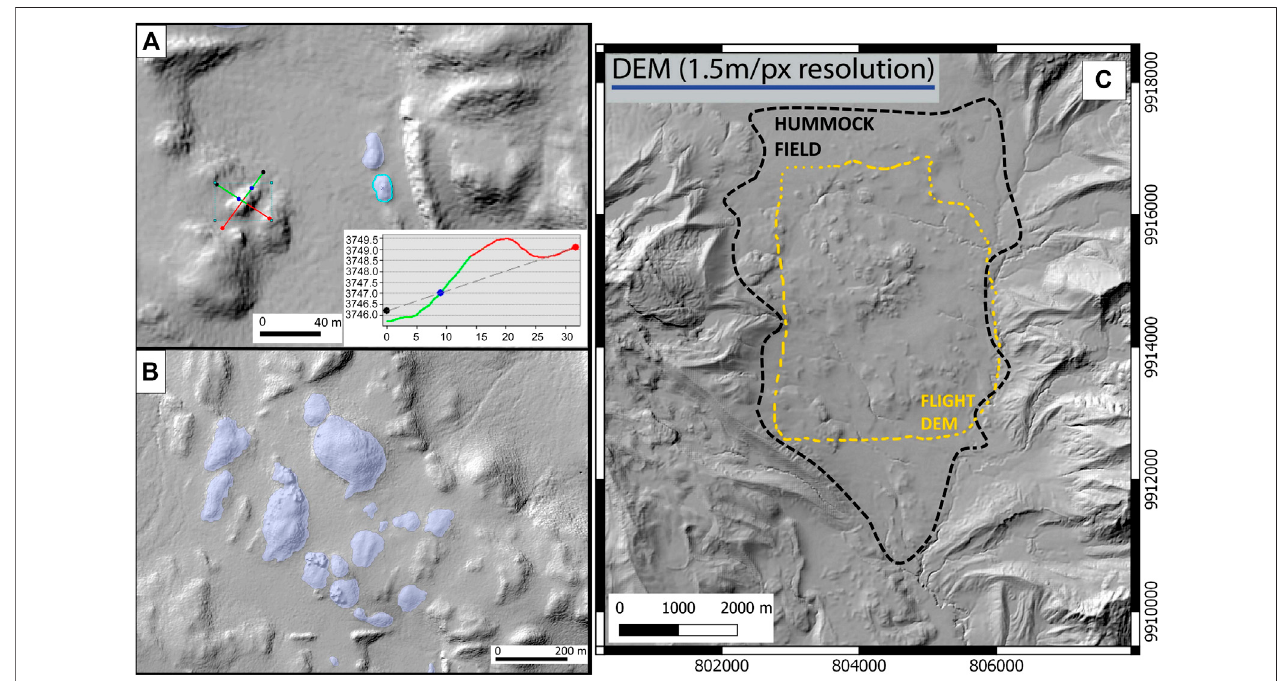
FIGURE 7 | DEM with a high spatial resolution of 1.5 m/pix which is a fi nal result of the unmanned aerial vehicle survey. Insets (A,B) show polygons used to delimitatehummocksinordertoderivetheirvolume. (C) .Theperimeterofthemappedhummock fi eldisdelimitedbyabrokenblackline,whiletheyellowlinedelimitsthe fl ight paths. BVD, Buenavista